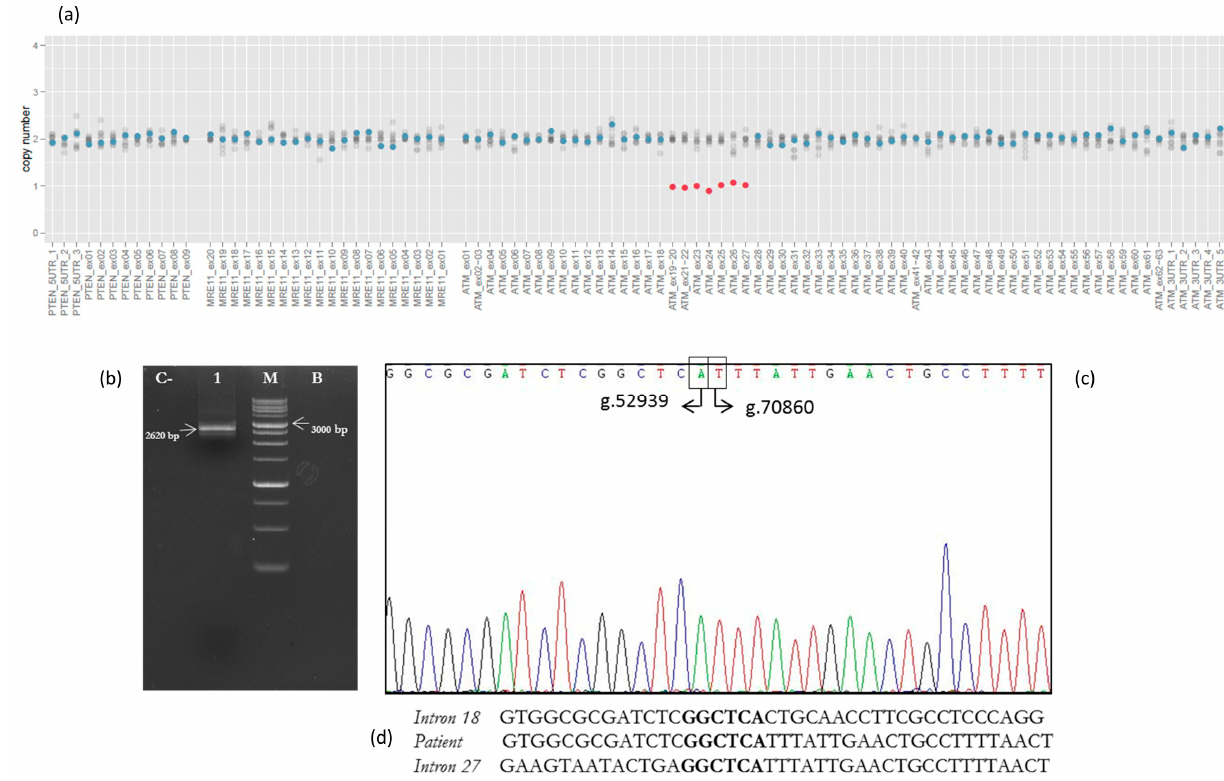
Figure 2. Characterization of exon 19–27 deletion in the ATM gene. ( a ) Copy number variation (CNV) analysis by Sophia DDM® software v.4.2. Amplicon coverage: ATM amplicons related to exons 19–27 show a copy number (CN) value of 1 (normal value: CN = 2). ( b ) Genomic DNA was amplified using specific deletion primers (Del18F and Del28R). The mutant allele gives rise to a 2620 bp fragment. C − : negative control (wild-type DNA), Lane 1: patient, M: marker, B: blank. ( c ) The electropherogram of the 2620 bp PCR fragment, containing the deletion’s breakpoint, showed a wild-type sequence until the nucleotide g.52939A (NG_009830.1) of ATM intron 18. The following sequence corresponded to the ATM intron 27 starting from the g.70860T nucleotide. ( d ) The very short homologous sequence of six nucleotides (GGCTCA) identified at the breakpoint